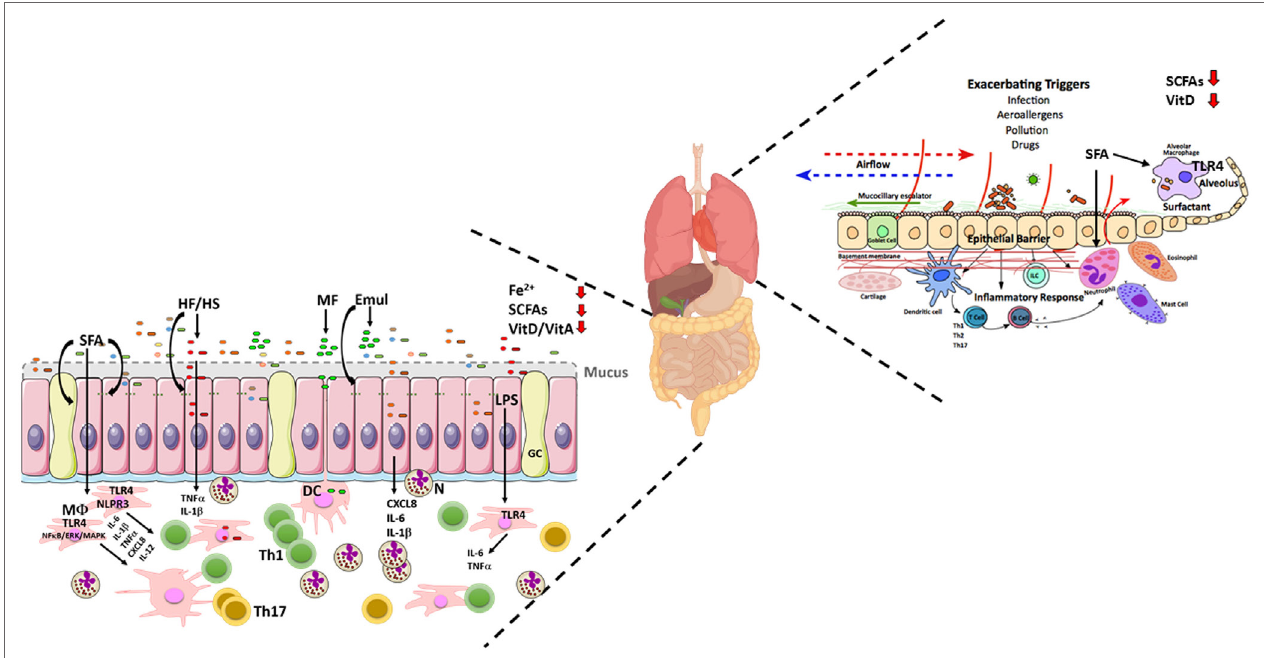
FiGURe 4 | Schematic illustrating the nutrient factors affecting microbial and host responses in the inflamed gut in inflammatory bowel disease (IBD) and the lung in Asthma. In both IBD and Asthma genetic susceptibility, microbiota, and dietary changes result in disease development and inflammation. Dysfunctional epithelia barrier function allows for malabsorption of nutrients, inappropriate immune sampling, and colonization of the gut by pathobionts and subsequent disease exacerbation. In the lung, environmental triggers stimulate inflammatory and allergic reactions resulting in mucus hypersecretion, epithelia, and tissue remodeling and resulting compromised of lung function. This microenvironment change allows for microbial changes which allow for increased respiratory infections in asthmatic patients. Both IBD and asthma pathogenesis is related to reduced microbiota-derived SCFAs, malabsorption of iron and Vitamins and reduced gut-derived SCFA result in a trend toward an inflammatory sensing of the mucosa associated microbiota. A diet high in SFA increases TLR4 sensing and subsequent inflammatory reactions to the microbiota resulting in disease progression. This dysregulated mucosal inflammation changes the epithelia barrier function and subsequently alters the microbiota of both sensitive immune sites displaying the characteristic phenotypes associated with both IBD and asthma. Lung figure adapted from Ref. (41). Abbreviations: CXCL8, C–X–C Motif Chemokine Ligand 8; DCs, dendritic cells; Emul, emulsifier; GC, goblet cell; HF/HS, high-fat/high sucrose; ILC, innate lymphoid cells; IL-1 β , interleukin 1 beta; IL-6, interleukin 6; IL-12, interleukin 12; Fe2 + , iron; LPS, lipopolysaccharide; M Φ , macrophage; MAPK/ERK, mitogen-activated protein kinase/extracellular signal-regulated kinase; MF, milk fat diet; N, neutrophils; NF κ B, nuclear factor kappa-light-chain-enhancer of activated B cells; PPAR γ , peroxisome proliferator-activated receptor gamma; SFA, saturated fatty acids; SCFAs, short-chain fatty acids; TGF β , transforming growth factor beta; Th, T helper; TNF, tumor necrosis factor; TLR4, toll-like receptor 4; VitA, vitamin A; VitD, vitamin D; healthy bacteria phyla— , bacteroides; , firmicutes; , adherent and invasive Escherichia coli (AIEC); , Bilophila wadsworthia ; , other altered bacterial spp; , compromised barrier